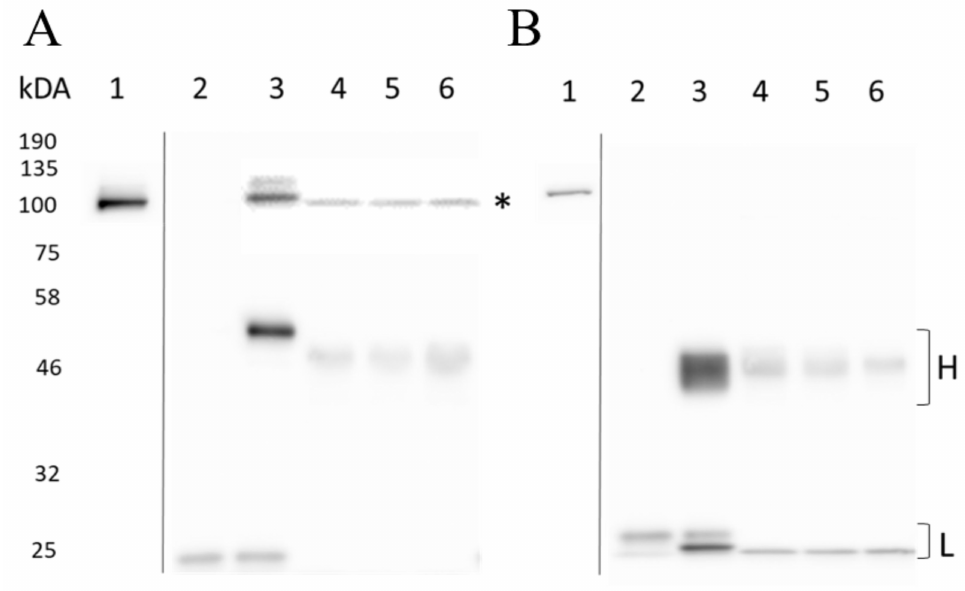
Figure 9. Comparison of antibodies and Affimers for immunoprecipitation of EPAC1 and EPAC2 using. ( A ) EPAC1 and ( B ) EPAC2 U20S cells were harvested in 0.5 mL of RIPA buffer, containing protease inhibitor cocktail, and lysed for 30 min by rotation at 4 ◦ C. Extracts were centrifuged and cell lysates were collected, including inputs (total EPAC protein) (lane 1). To each cell lysate, 4 µ g of rabbit IgG antibody (lane 2), 1.4 µ g of 5D3 (A: lane 3) or 2.5 µ g of 5B1 antibody (B: lane 3),